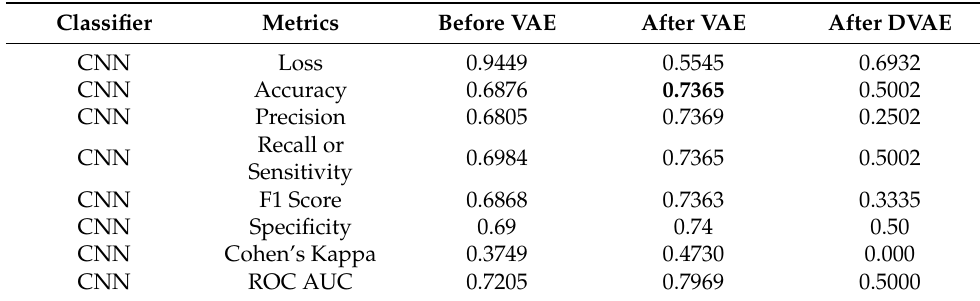
Table 3. Comparative analysis between classification results before and after implementing VAE. The best results are highlighted in bold.